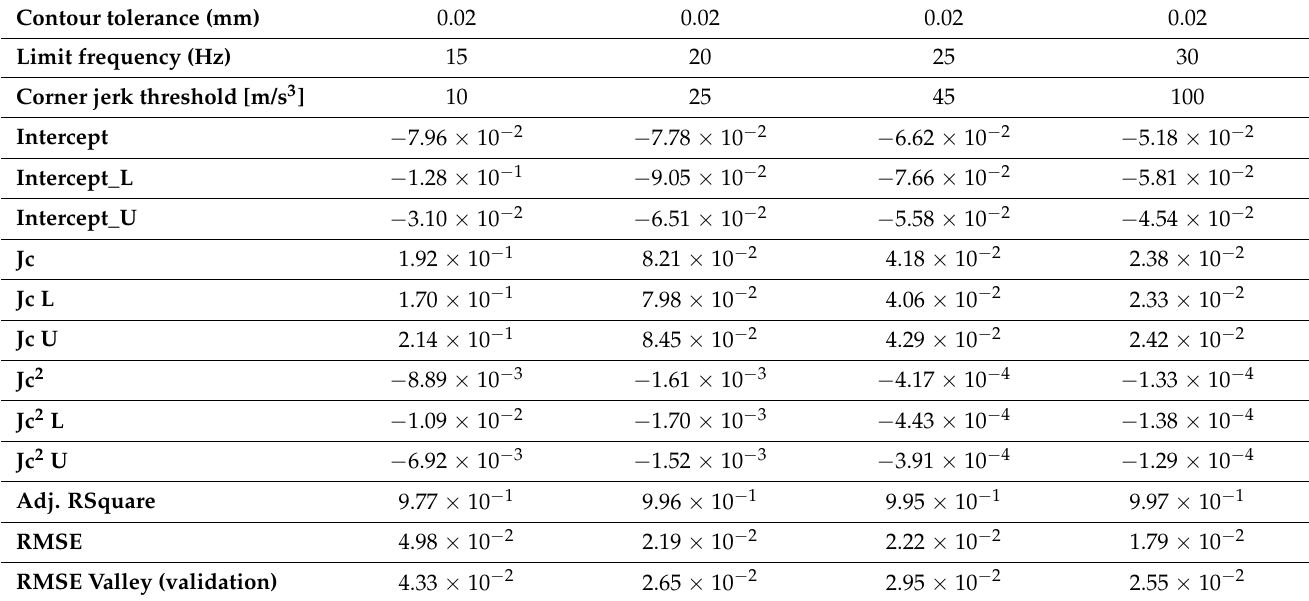
Table A3. Parameters of regression models describing the dependence of the TV coefficient on the corner jerk limit (denoted by J c ), results for contour tolerance of 20 µ m. Postfixes L and U denote the lower and upper limits of the 95% confidence intervals, respectively.